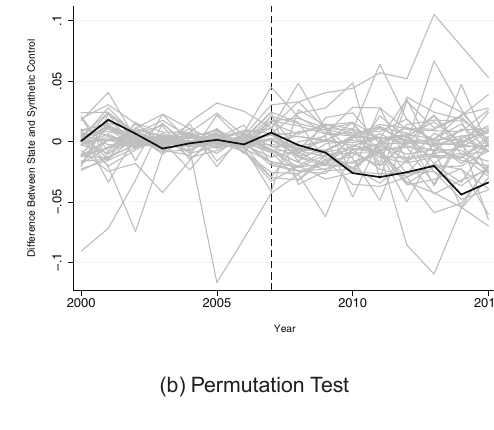
Figure A21 Native Low-skilled Male Participation